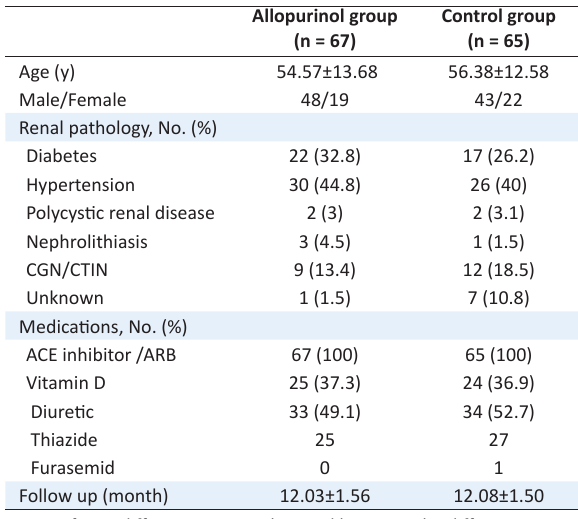
Table 1. Demographic characteristics of the patients